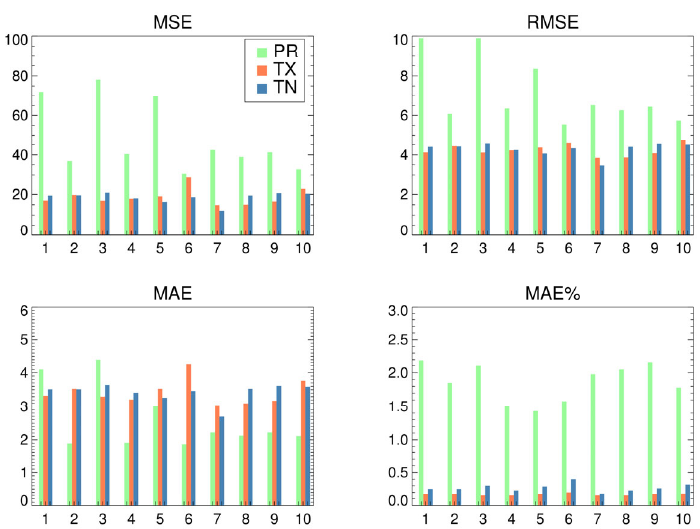
Figure 4. Skill metrics calculated between paired model—observed data to estimate the accuracy of the model in precipitation (PR), maximum (TX) and minimum (TN) temperature.